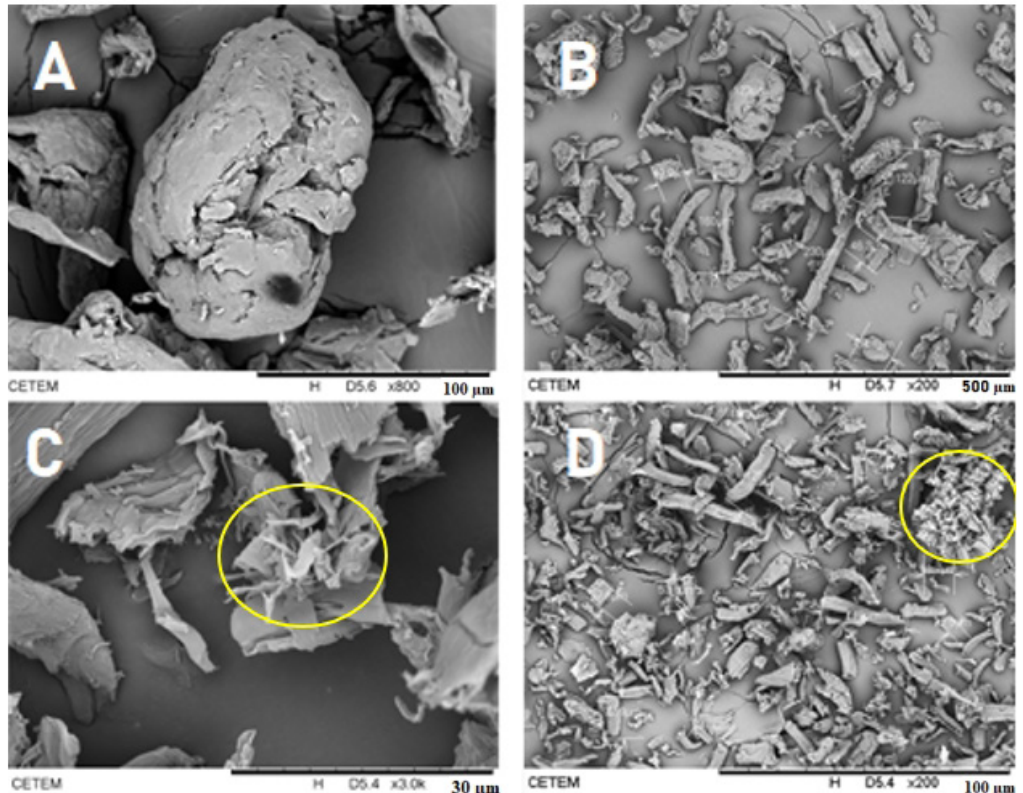
Figure 1. SEM images obtained for MCC (micrographs A and B) and sMCC (micrographs C and